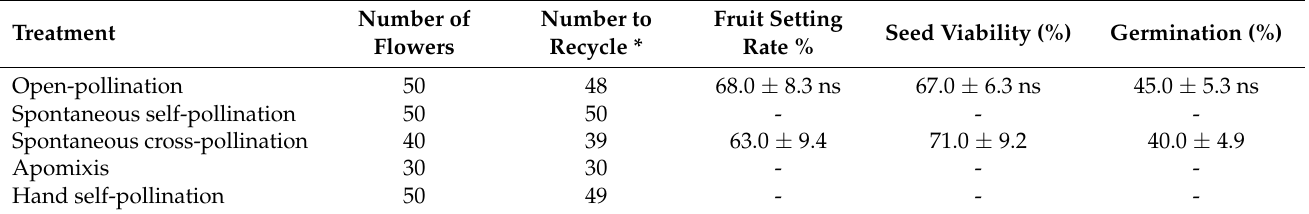
Table 1. Mean fruit production ( ± SD) in F. aurea plants exposed to five experimental pollina- tion applications.